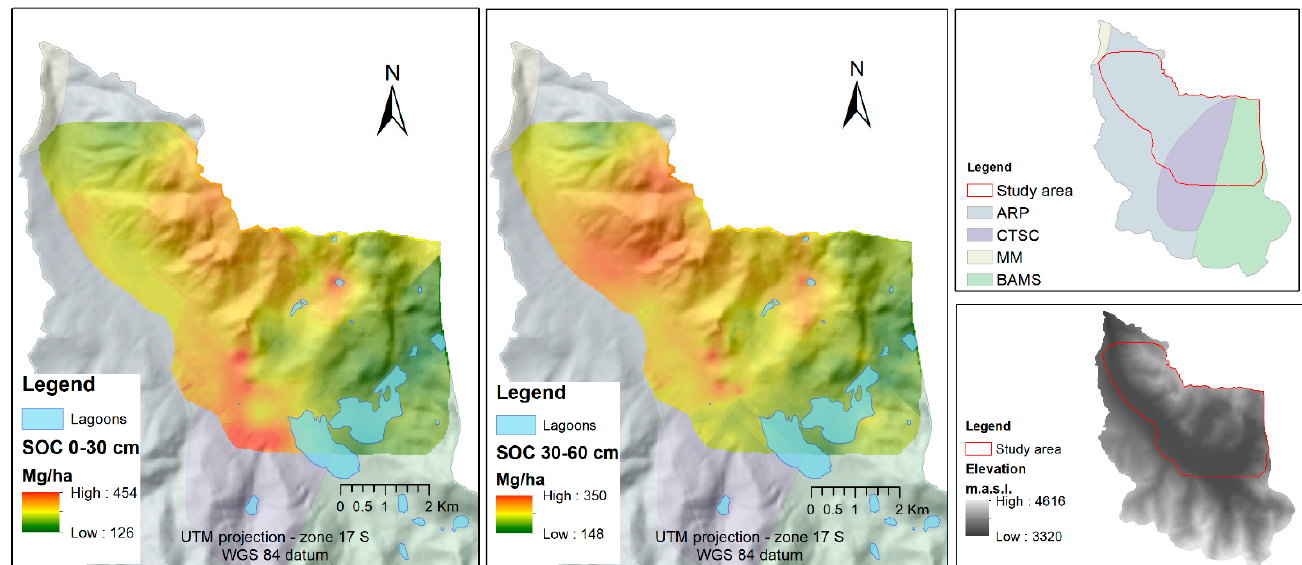
Figure 4. SOC estimation for 0–30 cm profile and 30–60 cm profile-influence area. ARP: Andesites to rhyolites, pyroclasts; CTSC: Clays, tuffs, sandstones, conglomerates; MM: Metagreywacke, metalavas; BAMS: Basaltic and andesitic metalavas, schists.